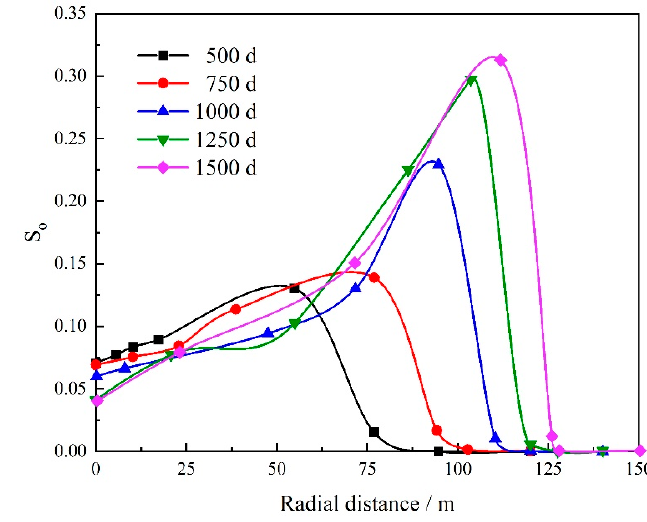
Figure 9. Radial oil saturation distribution at different times.